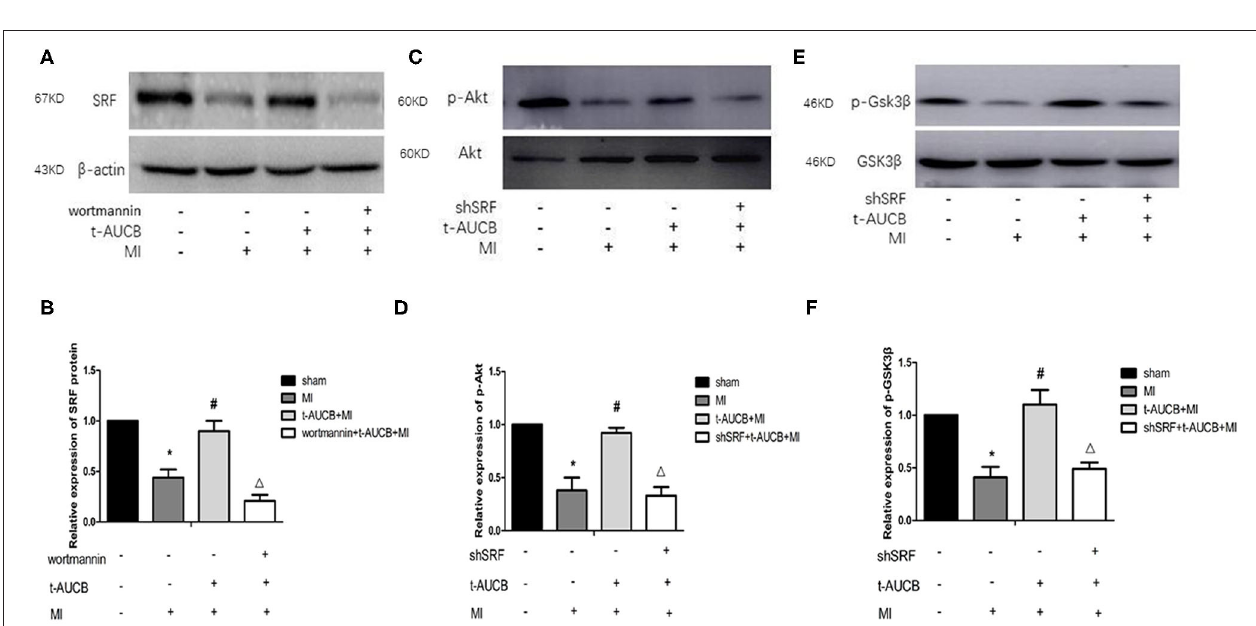
FIGURE 4 | The interaction between SRF and PI3K/Akt/GSK3 β pathway during the regulation of miR-1 by sEHis. One week after intervention with t-AUCB in mice with myocardial infarction (MI), PI3K inhibitor wortmannin was injected into the tail vein, then serum response factor (SRF) was detected; on the other hand, MI mice were injected with effective SRF small hairpin RNA sequence adenovirus (shSRF) and treated with t-AUCB, the expressions of p-Akt and p-GSK3 β were detected by western blot. (A) After blocking the PI3K pathway, the effects of t-AUCB on SRF were examined. (B) Relative protein expression of SRF after the treatment of wortmannin. (C) After silencing SRF, the effects of t-AUCB on Akt and p-Akt were examined. (D) Relative protein expression of Akt and p-Akt. (E) After silencing SRF, the effects of t-AUCB on GSK3 β and p-GSK3 β were examined. (F) Relative protein expression of GSK3 β and p-GSK3 β . Compared with the sham group, * P < 0.05, compared with the MI group, # P < 0.05, compared with the t-AUCB + MI group, 1 P < 0.05; all n =